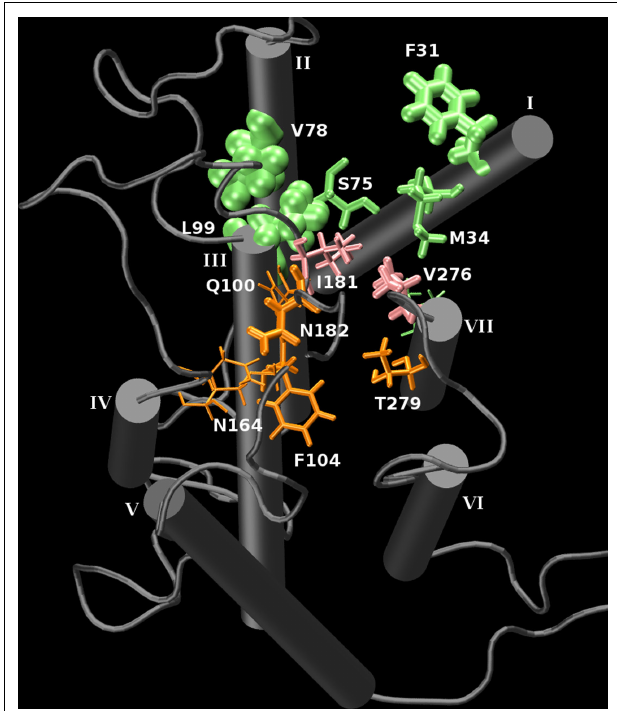
FIGURE 7 |A graphical representation of the interaction frequency between the carbonyl oxygen of isoamyl acetate and hOR 17-209 through 10ns of MD. Green represents the primary binding pocket and orange represents a second binding pocket which is sampled by the ligand for 2ns. Pink residues line the saddle point between the two regions.The larger the residue’s appearance, the higher the interaction frequency.The N- and C-termini were removed for